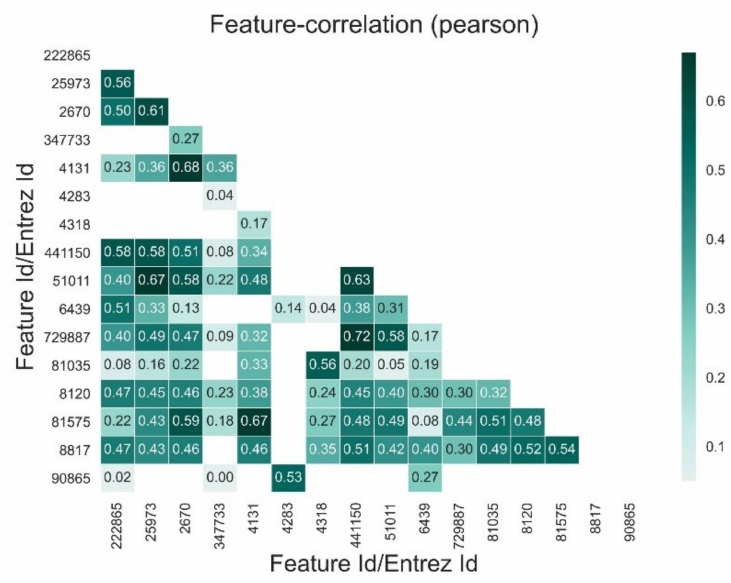
Figure 11. Positive Feature Correlation Heat Map.